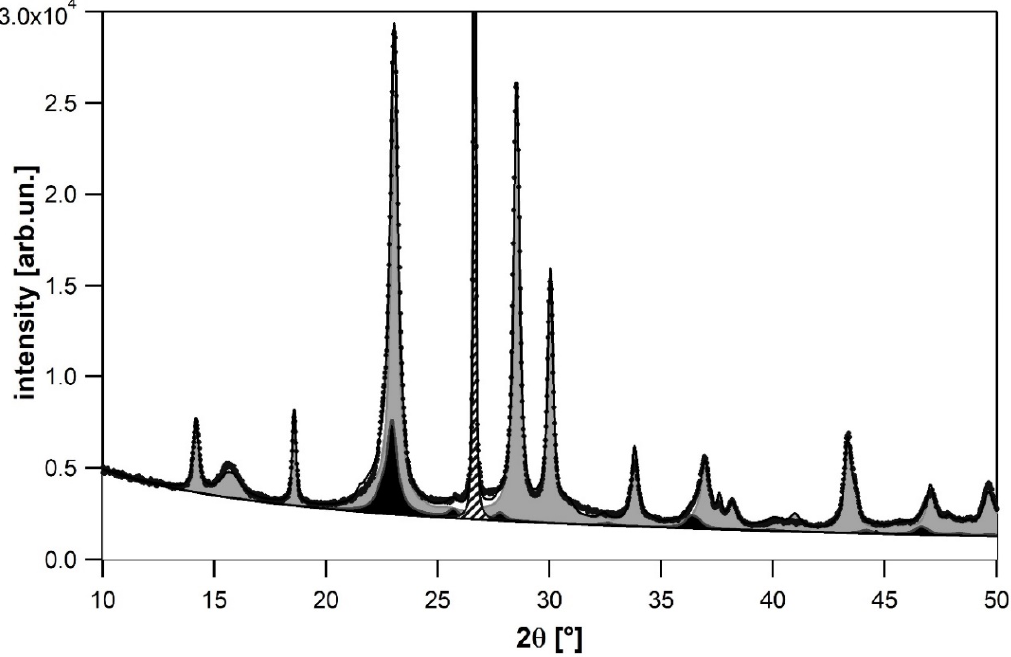
Figure 2. Measured (black dots) and calculated (different grey shaded areas) diffraction patterns of the sample catalyst C after the catalytic test. Calculated phase contents yielded: 90.41% (VO) 2 P 2 O 7 (grey), 8.72% β -VO(PO 3 ) 2 (black) and 0.87% graphite (dashed).